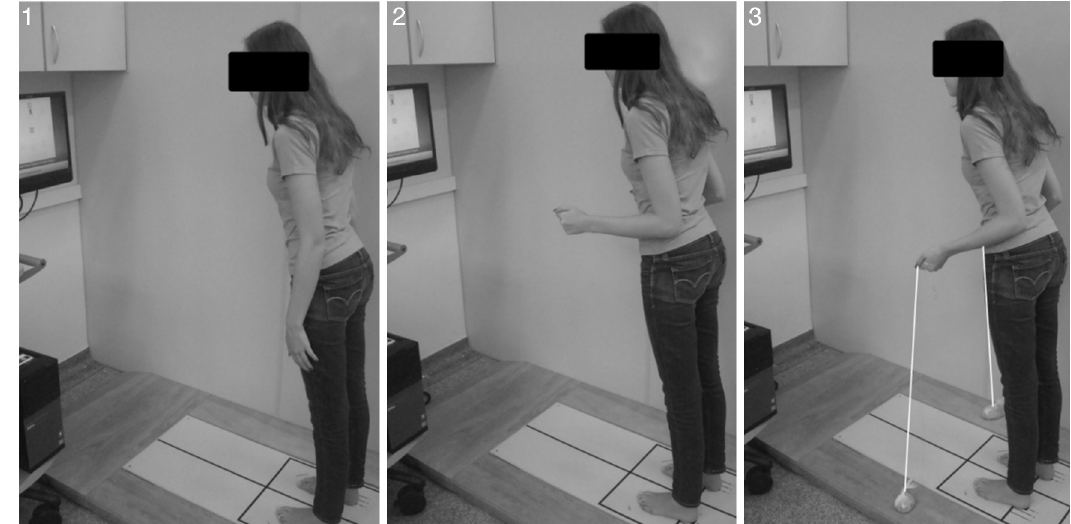
Figure 2 Positions adopted during evaluations using the Balance Master ® equipment. Position 1, standing with the arms along the body; position 2, standing with the elbows bent at 90 ◦ (simulating holding the anchors); and position 3, with elbows bent at 90 ◦ holding the